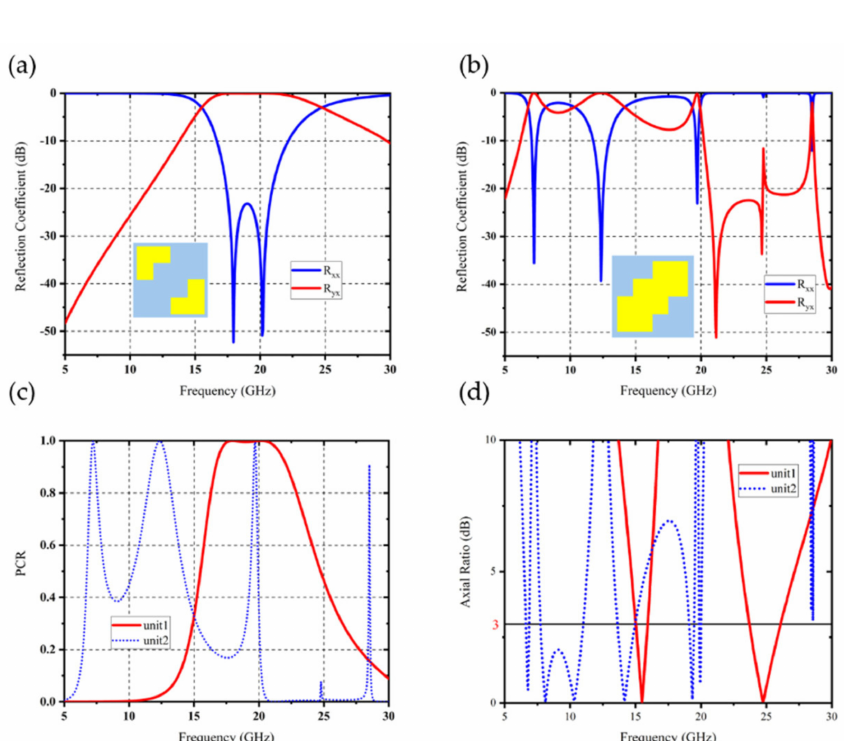
Figure 2. Simulation results of unit. ( a ) Reflection coefficient of unit 1. ( b ) Reflection coefficient of unit 2. ( c ) PCR for units 1 and 2. ( d ) AR for units 1 and